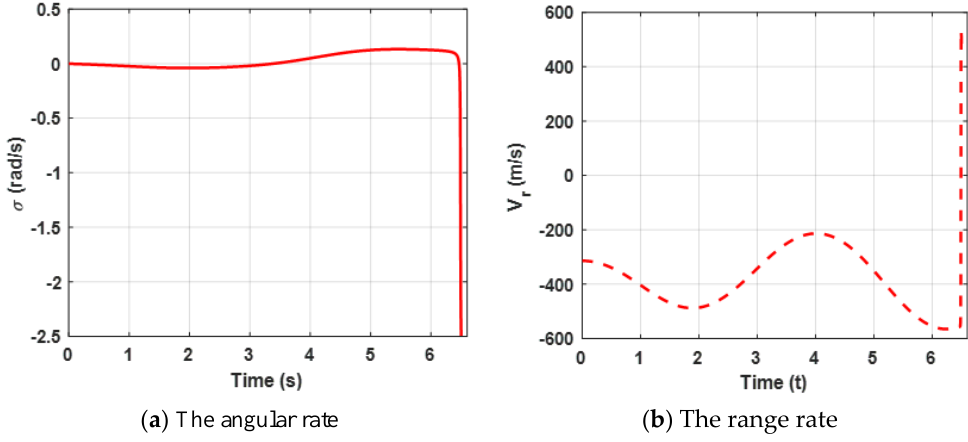
Figure 10. Curves of the angular rate and the relative velocity with unknown uncertainties.